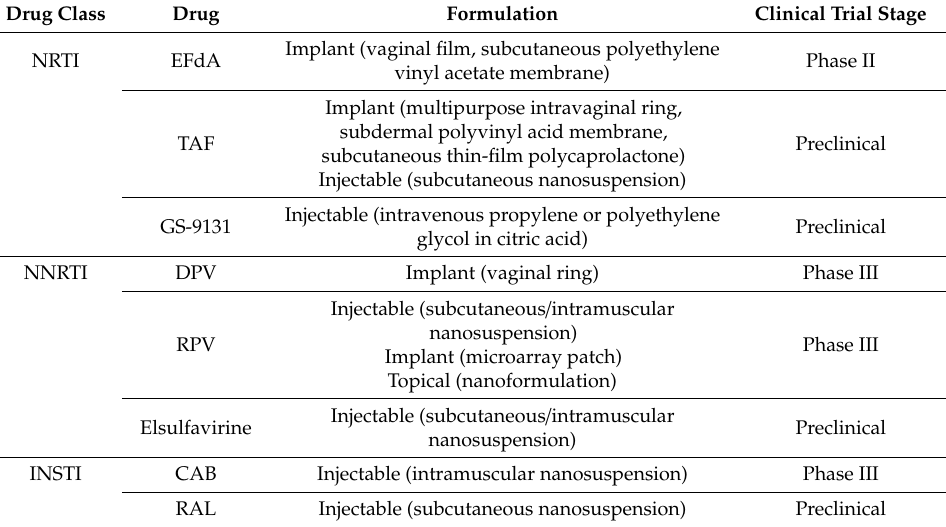
Long-acting antivirals targeting HIV-1 RT and HIV-1 IN. NRTI, nucleos(t)ide RT inhibitors; NNRTI, non-nucleoside RT inhibitors; INSTI, integrase strand transfer inhibitors; EFdA, 4-ethynyl-2-fluoro-2-deoxyadenosine; TAF, tenofovir alafenamide fumarate; DPV, dapivirine; RPV, rilpivirine; RAL,